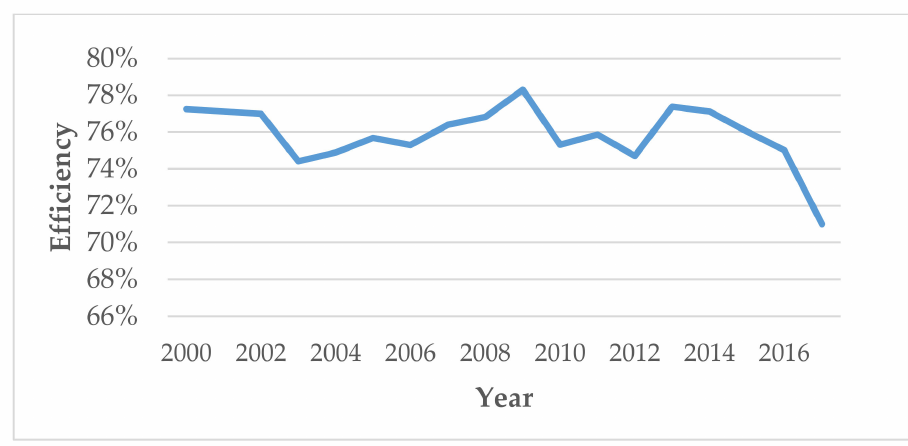
Figure 1. Electricity sector reform performance trend in SSA from 2000 to 2017.